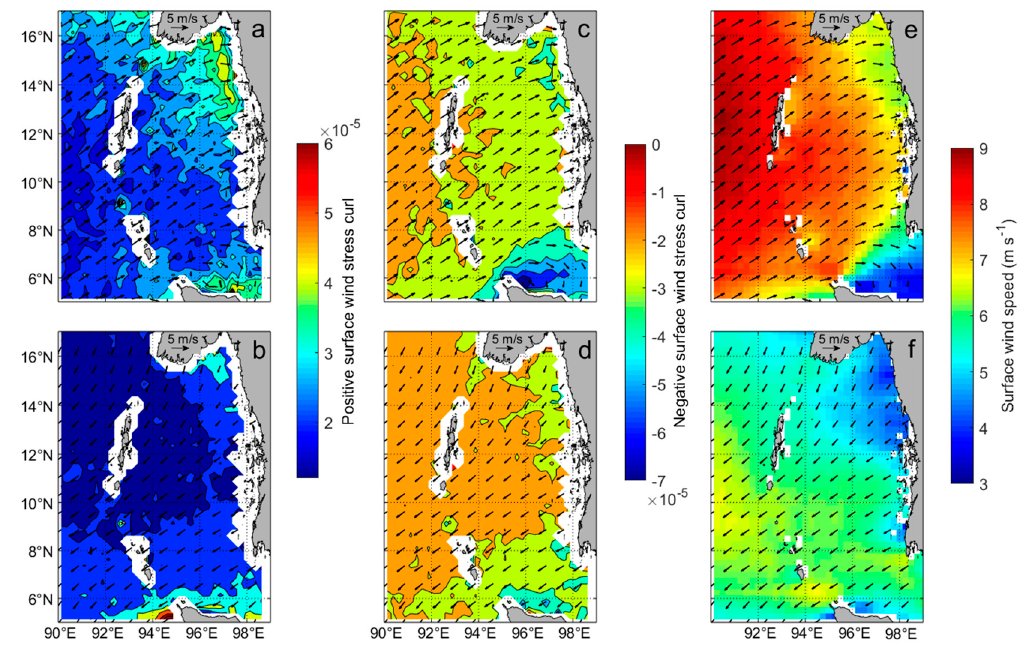
Figure 20. Multi-year mean positive wind stress curl in summer ( a ) and winter ( b ); multi-year mean negative wind stress curl in summer ( c ) and winter ( d ); multi-year average sea surface wind speed in summer ( e ) and winter ( f ). The vectors correspond to surface wind speed and direction.